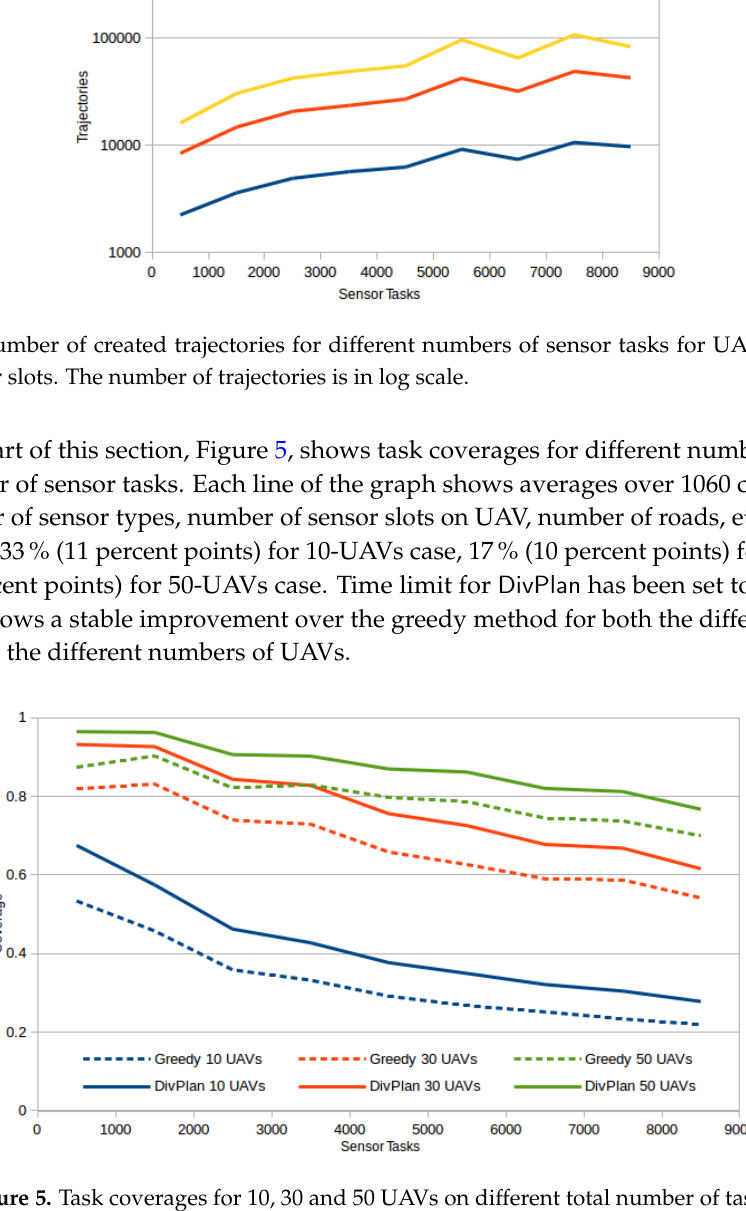
Figure 5. Task coverages for 10, 30 and 50 UAVs on different total number of